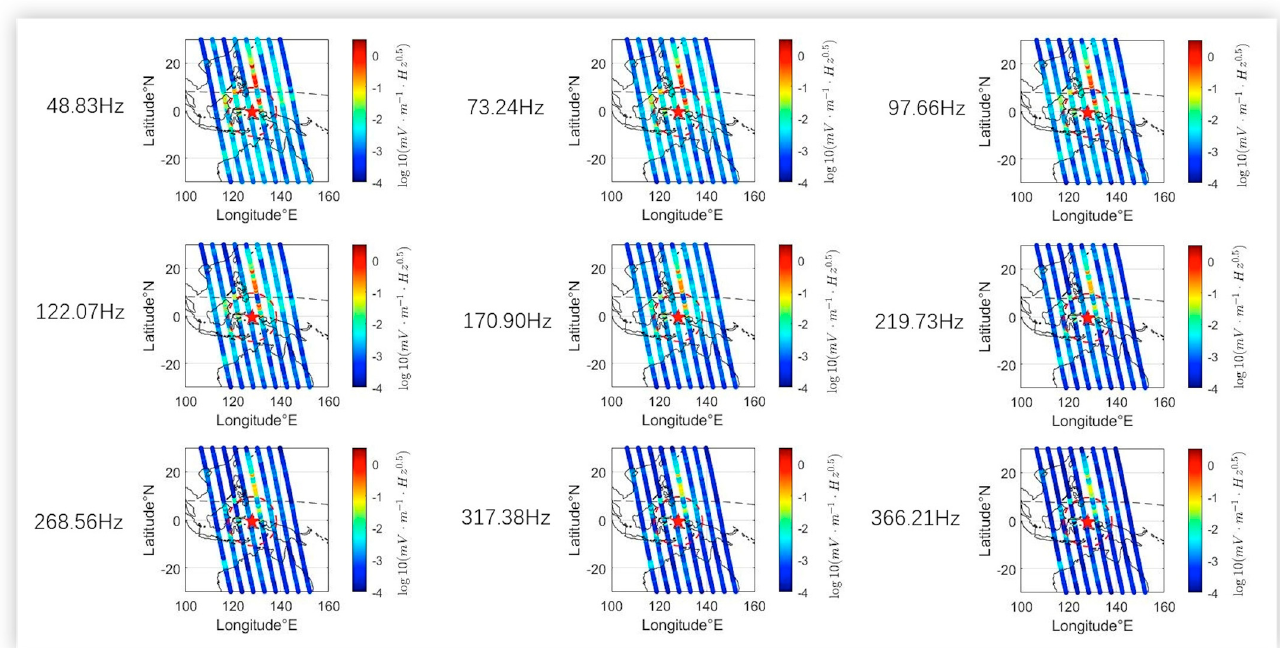
Figure 2. Using the earthquake No. 1 as the object, the distribution of observational values of PSD of the electric field on the ascending orbits from 4 July to 8 July. From left to right, the dotted lines indicate the satellite trajectories on 8, 4, 5, 6, 7, 8, 4, and 5 July. The red stars, dashed circles, and black dashed curves indicate the epicenters of two earthquakes, the estimated seismogenic zones, and the magnetic equators, respectively.